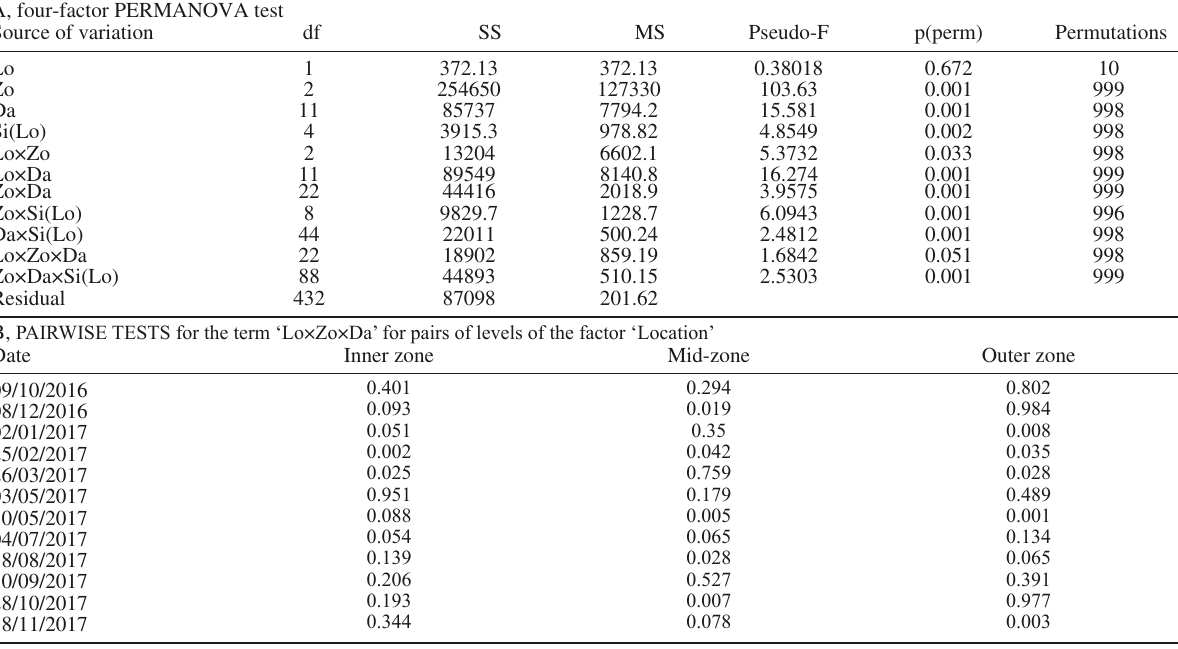
Table 2. – A, summary of a four-factor PERMANOVA univariate test (with location , zone , date and site nested in location ) comparing overstory cover values from all the samples. Lo, location ; Zo, zone ; Da, date ; Si, site ; (*) Monte Carlo p-value=0.001. B, pairwise tests for the A, four-factor PERMANOVA test Source of variation